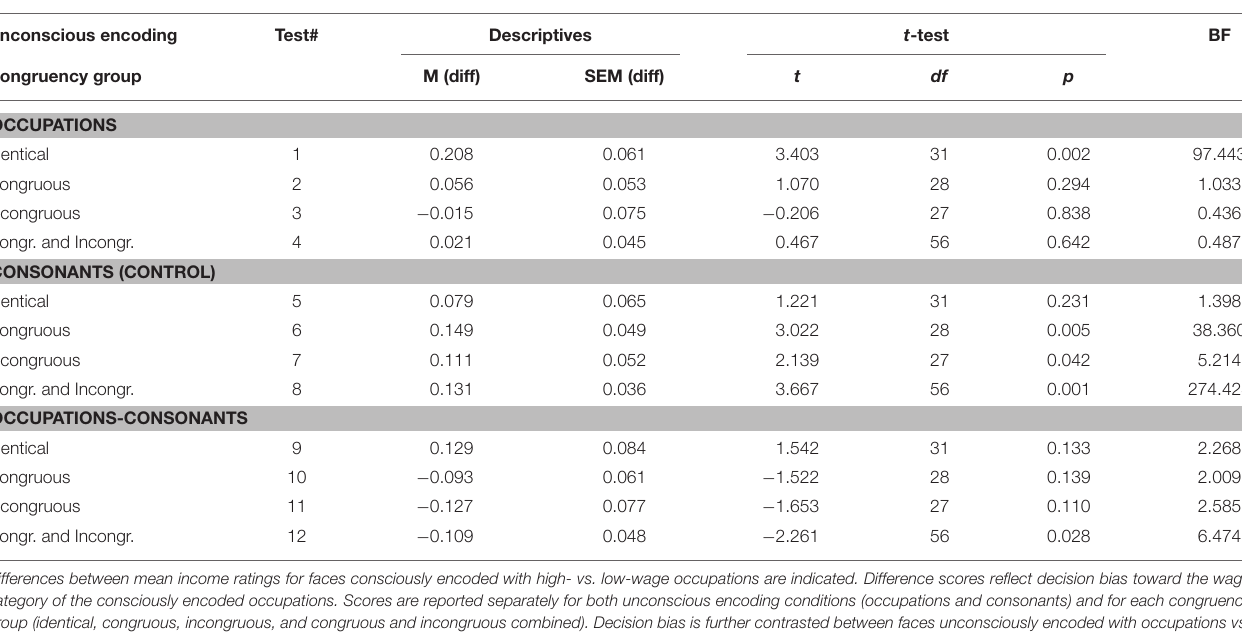
TABLE 2 | Decision bias toward consciously encoded occupations.